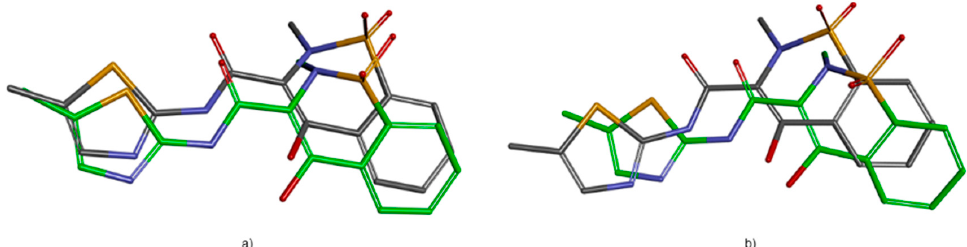
Figure 3. Overlay of meloxicam (MXM) conformation extracted from 4M11 ( a ) and 4O1Z ( b ) co-crystals (carbon shown in green) with the best docked conformer in cyclooxygenase (COX-2) and (COX-1) (carbon depicted in grey).